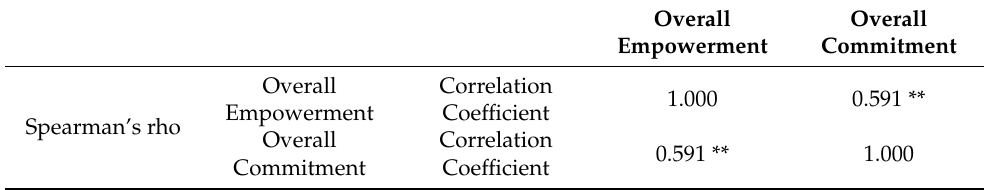
Table 6. The correlation between nurses’ empowerment and organizational commitment.